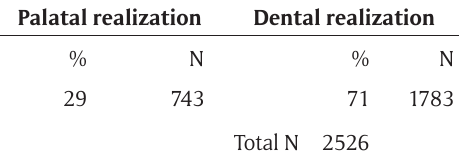
Table 8: Overall distribution of the realization of tokens of /ti/, /di/ in UP (2007 data).